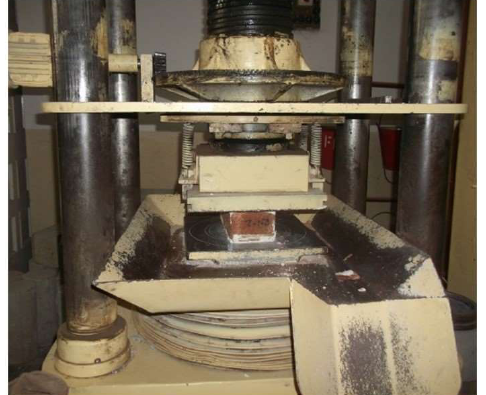
Figure 5. Compressive testing setup of capped brick.